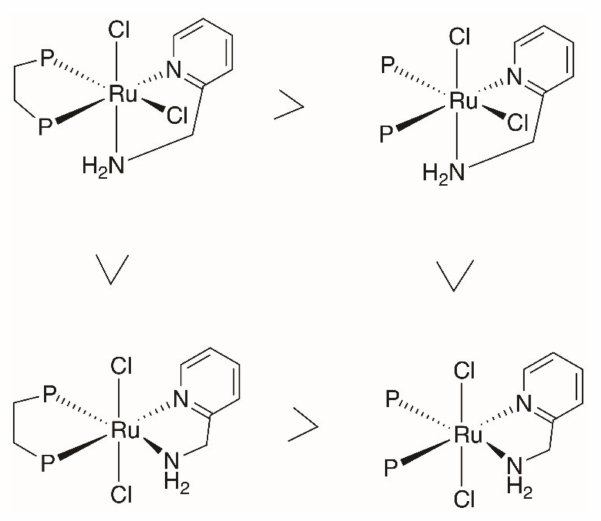
Figure 5. Relative activity of Ru(II) complexes as hydrogen transfer